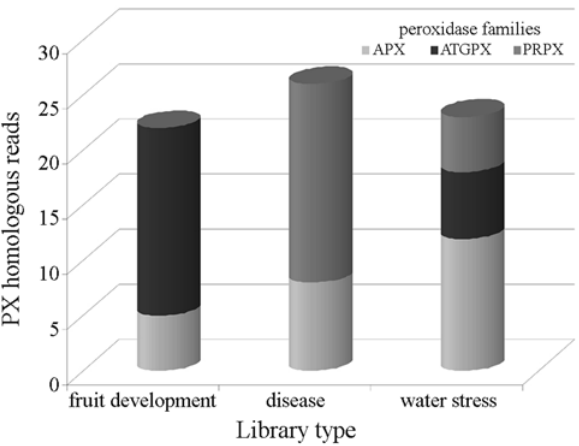
Figure 7 - Expression of peroxidase (PX) families in Poncirus trifoliata tissues from different developmental stages and stress conditions. The y-axis represents the number of reads showing sequence similarity to PX family members in BLAST searches. Citrus libraries were grouped ac- cording to the treatment: fruit development (700 series), disease (100, 200 and 300 series) and water stress (500 series). APX, L-ascorbate pero- xidase; ATGPX, Arabidopsis thaliana glutathione peroxidase; PRPX, peroxiredoxin peroxidase.